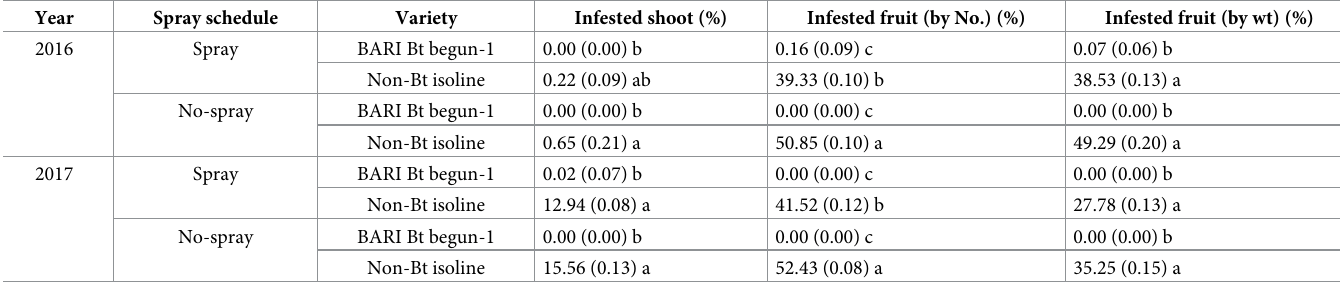
Table 6. Mean infestation 1 in brinjal by brinjal shoot and fruit borer (BFSB) relative to insecticides and varieties, OFRD, BARI, Bogra, Bangladesh.